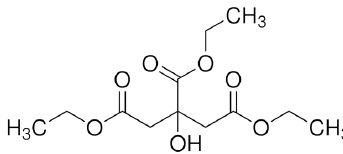
Figure 2. General structure of triethyl citrate (TEC).